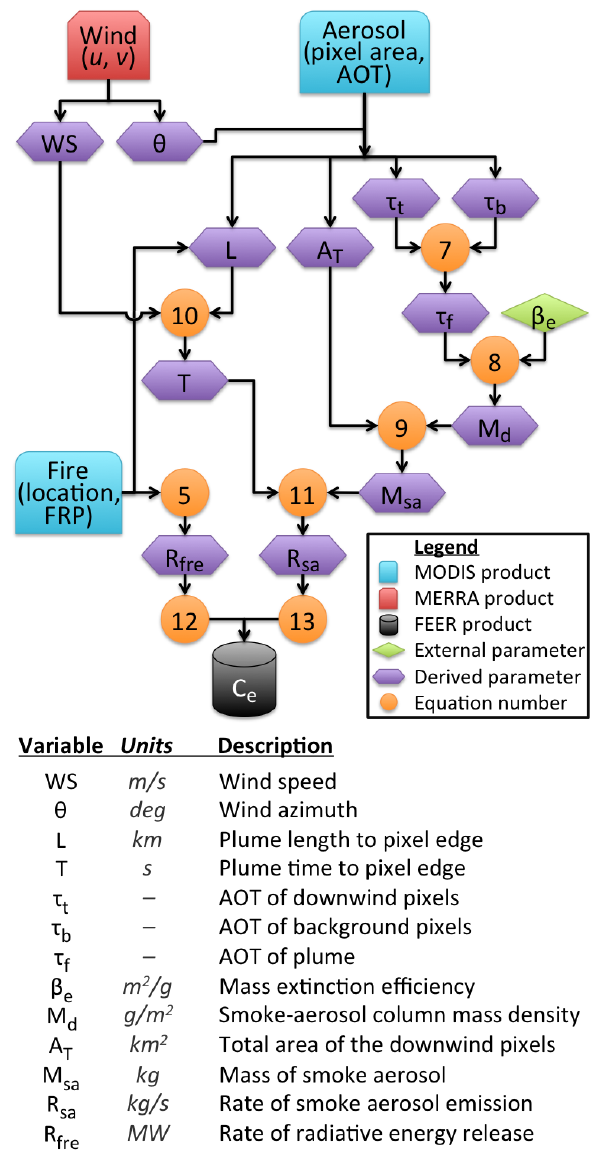
Fig. 1. Flowchart of the core of the algorithm leading to the derivation of Figure 1. Flowchart of the core algorithm for deriving FEER.v1 emission coefficients ( C e ) of smoke total particulate matter (TPM), FEER.v1 emission coefficients ( C e ) of smoke total particulate matter (TPM), as outlined in Sect. 4.1, showing only the relevant input and output variables/parameters and their associated equation numbers. This does not include the various sensitivity studies, data selection, re- finement, and filtration processes, as well as the post-processing gap-filling and evaluation steps that are described in the rest of Sect.